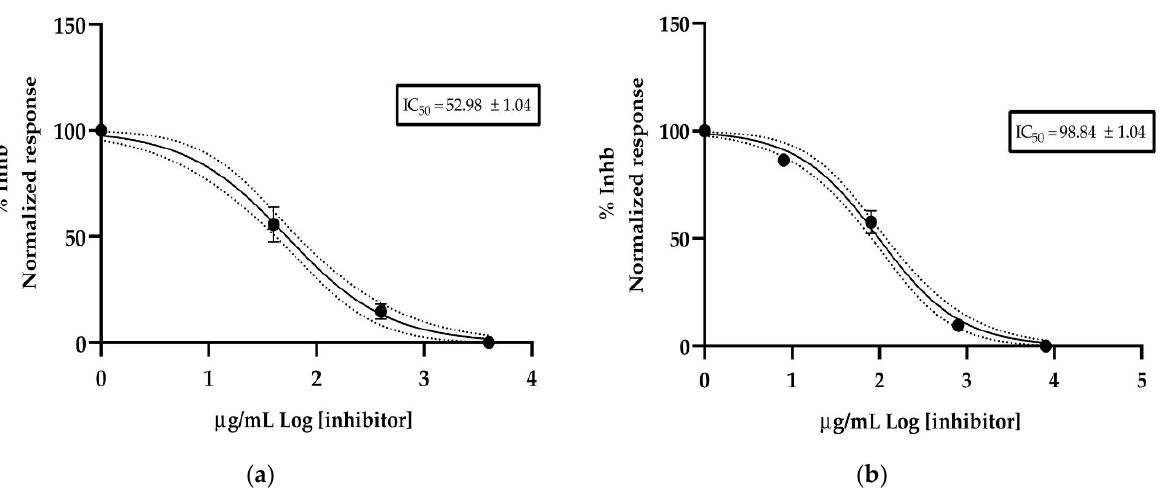
Figure 4. Half-maximum inhibitory concentration of S. muricata essential oil against acethylcholinesterase, ( a ) essential oil isolated from leaves and ( b ) essential oil isolated from fruits.